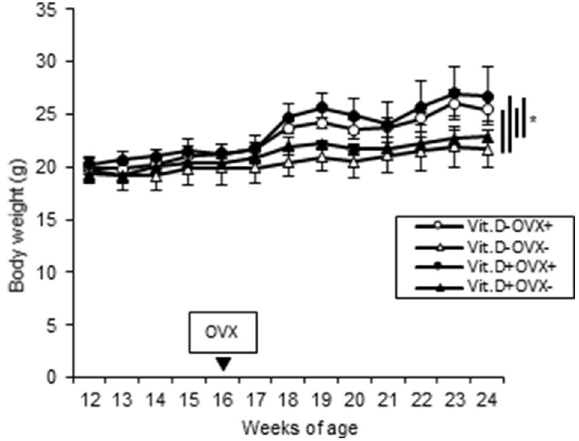
Figure 1. Body weight growth curves of ovariectomized (OVX +) and sham-operated (OVX−) female mice. Both groups were fed either a vitamin D–containing diet (Vit.D +) or diet without vitamin D (Vit.D−). Sham- operation or ovariectomy was performed at 16 weeks of age. * p < 0.05. OVX, ovariectomy.